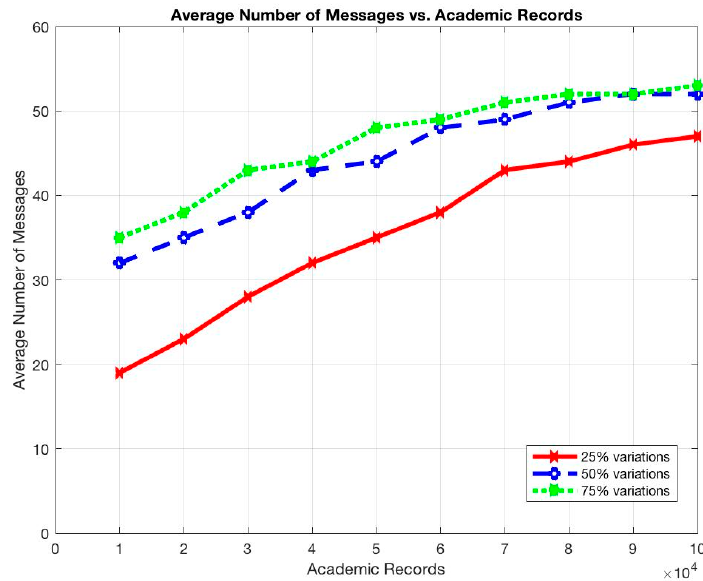
Figure 10. Average number of messages vs. academic records.